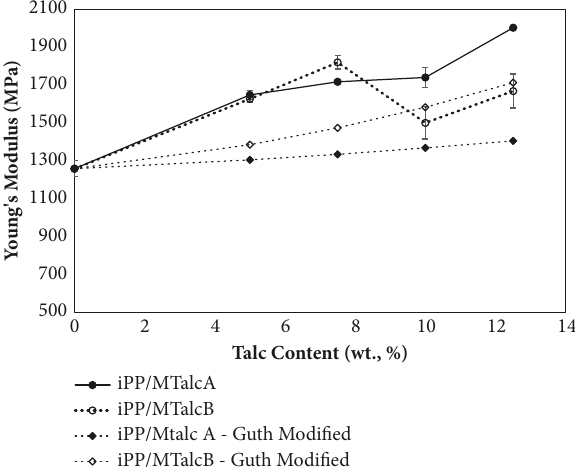
Figure 5: Young’s modulus versus filler content curves of compos- ites based on iPP/MTalc A and iPP/MTalc B, experimental data and predicted values determined by Halpin-Tsai Model.